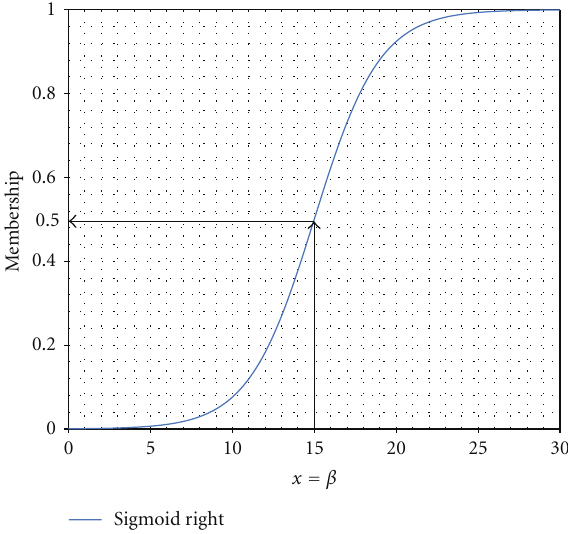
Figure 1: Sigmoid right membership function.